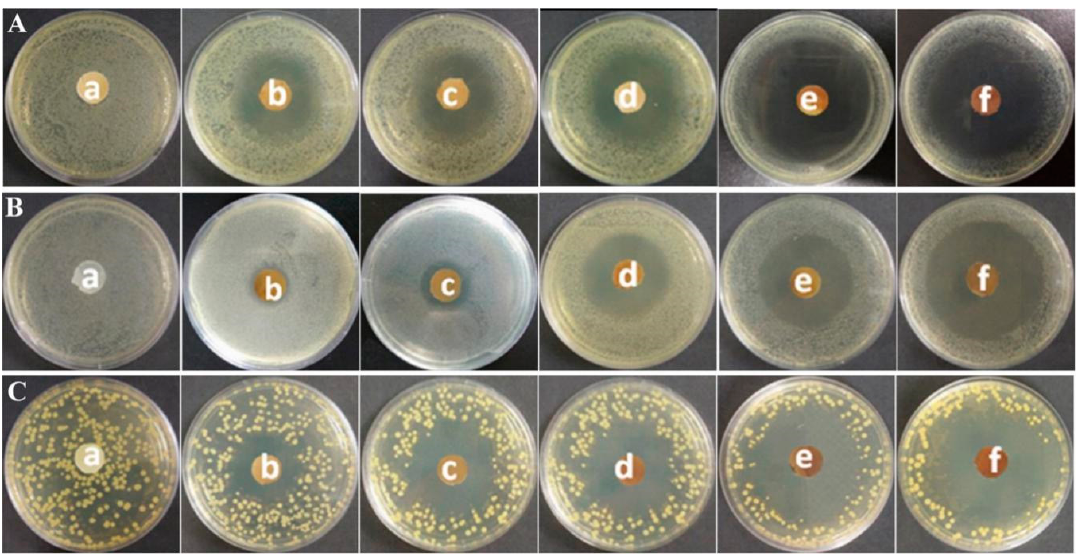
Figure 5. Optical images of inhibition zones: ( A ) E. coli , ( B ) C. albicans , ( C ) S. aureus . (In all plates, a–f are PC, PC 1 , PC 2 , PC 3 , PC 4 , and PC 5 films, respectively).